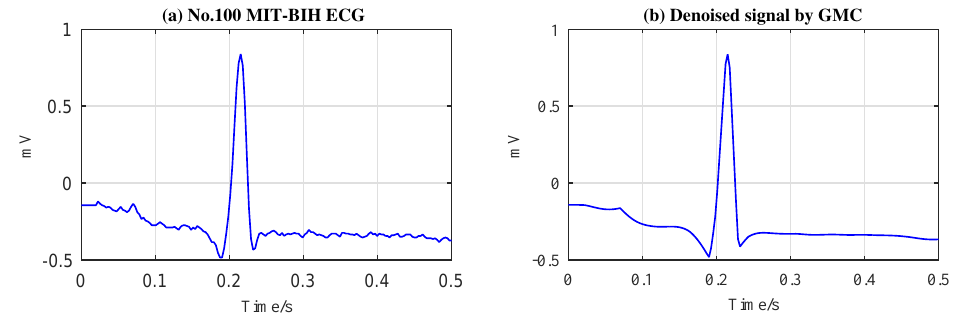
Figure 4. Denoising effect of original signal of MIT-BIH